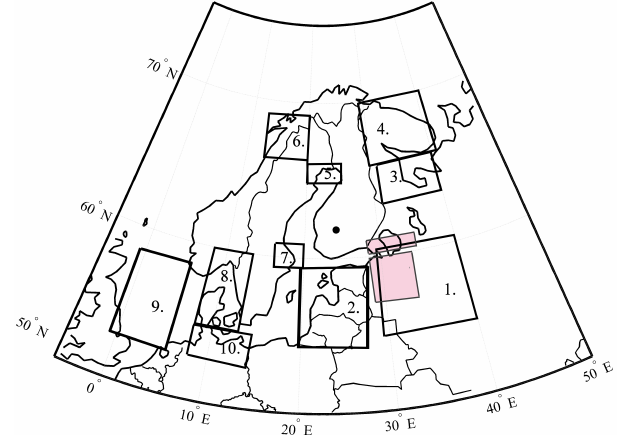
Figure 6. Main source areas of VOCs: (1) western Russia, (2) north- ern Poland, Kaliningrad and Baltic countries, (3) Karelia and the White Sea, (4) Kola Peninsula and Barents Sea, (5) Bay of Bothnia, (6) Coast of Norwegian Sea and northern Sweden, (7) Stockholm area, (8) Skagerrak, (9) North Sea and coastal areas, (10) northern Germany. Two forest fire source areas, limited in time, are marked by pink boxes. These are treated separately for the episodes (see Table 5). The SMEAR II site is marked by a dot in the